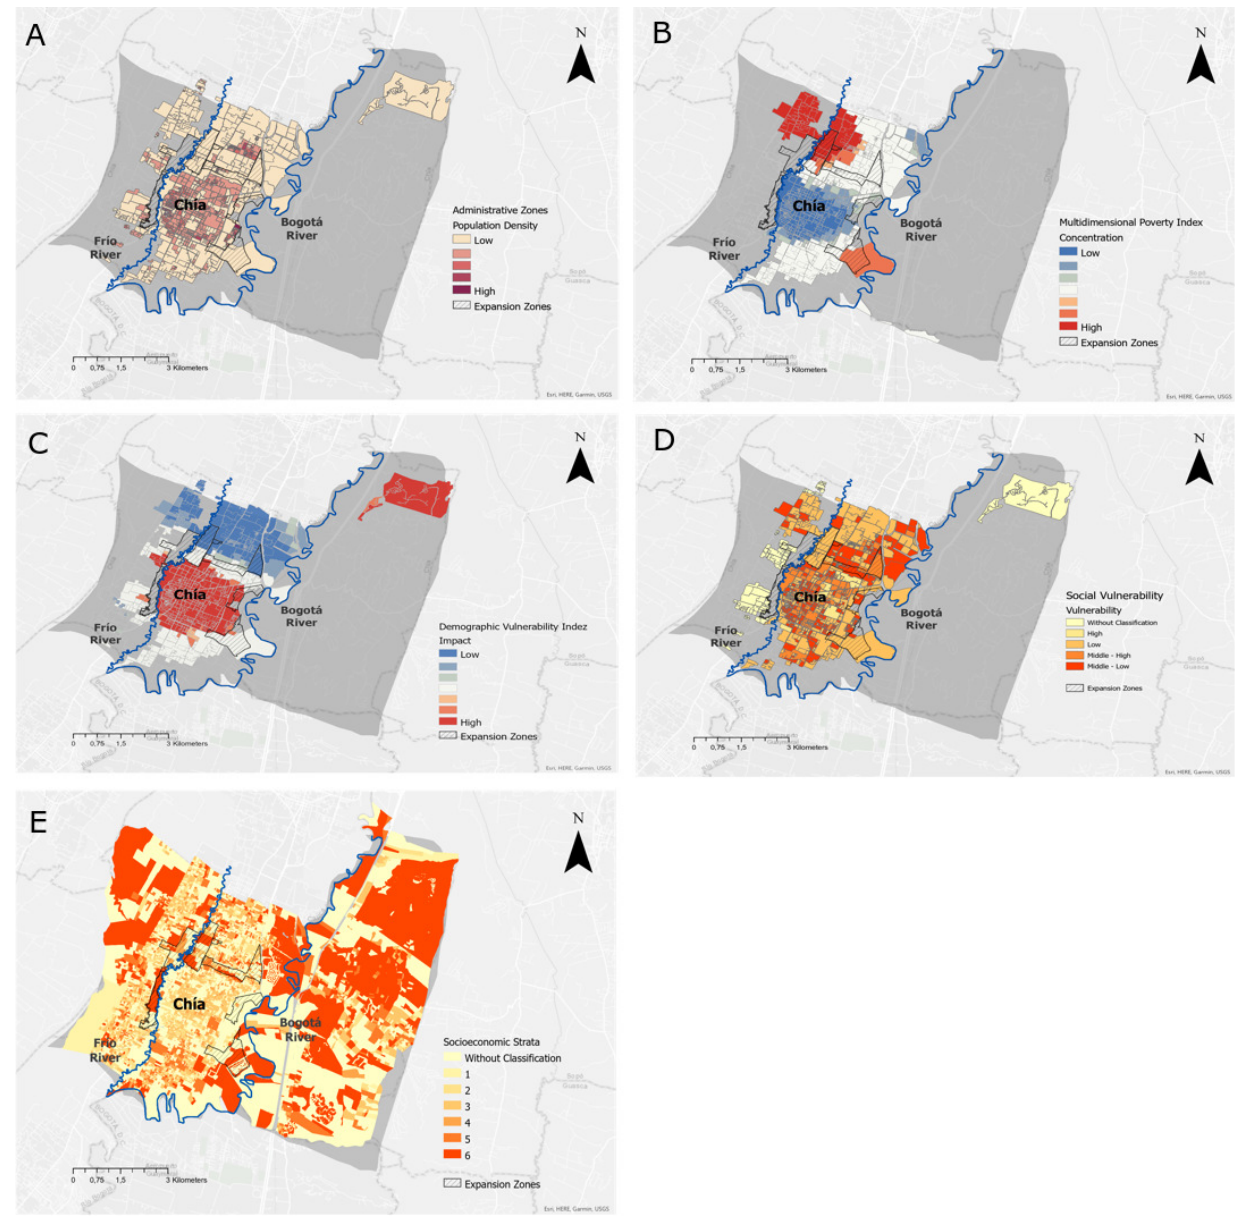
Figure 4. Social urban spatial structure vulnerability: (a) population density, (b) Multidimensional Poverty Index, (c) demo‐ graphic vulnerability index, (d) social vulnerability, and (e) socioeconomic